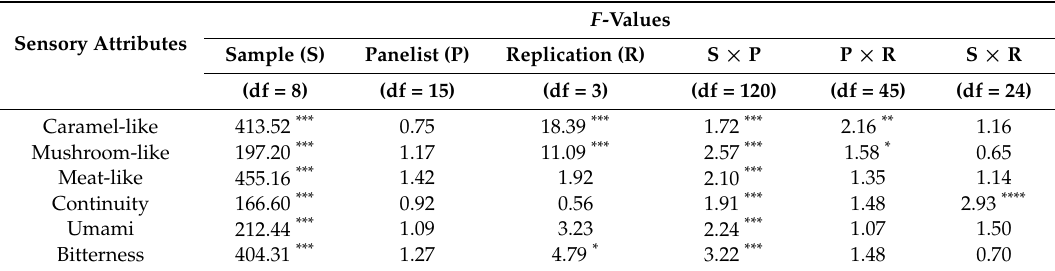
Table 2. Analyses of variance for the main effects and their interactions for each of the six attributes in sensory evaluation of MH and MRP100–140.